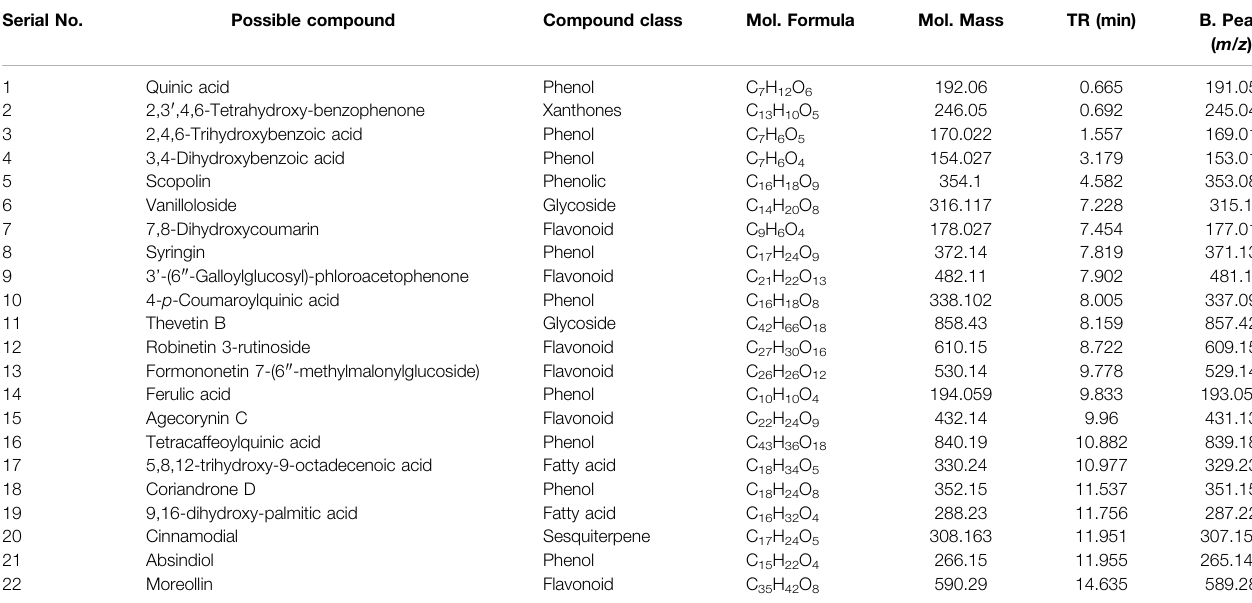
TABLE 3 | UHPLC-MS analysis of S. indicus methanol extract (negative ionization mode). Serial No. Compound class Mol. Formula Mol.